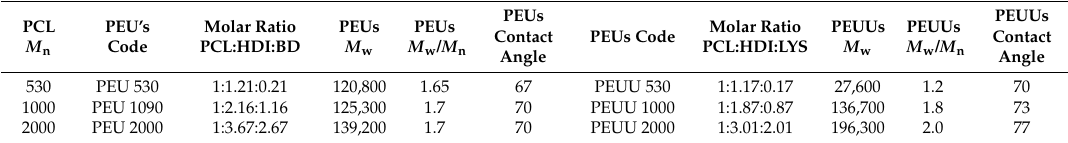
Polymers codes, reactant radio used, molecular weights obtained, polydispersity, and contact